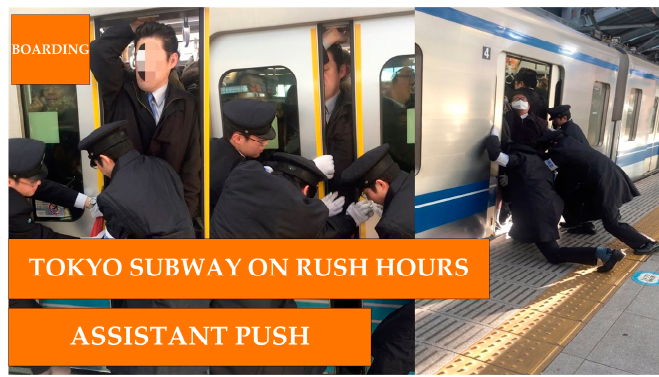
Figure 1. Common congestion and assistant push on the Tokyo Subway on rush hours.